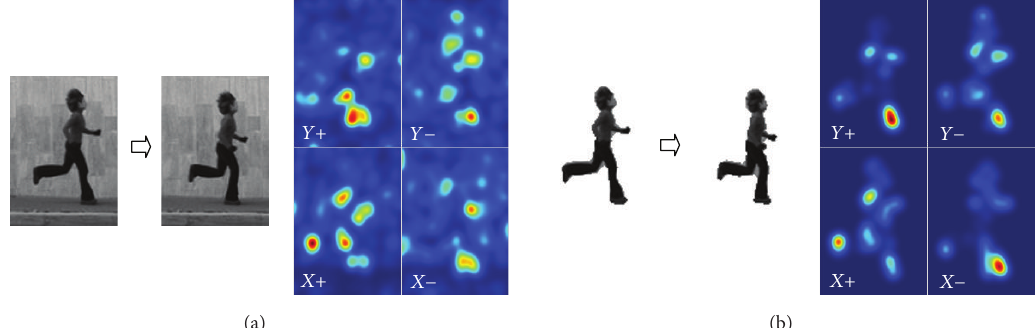
Figure3:Theopticalflowdescriptorsof“Lena run1.”(a)Showsopticalflowfromoriginalimages,and(b)showsopticalflowafterbackground